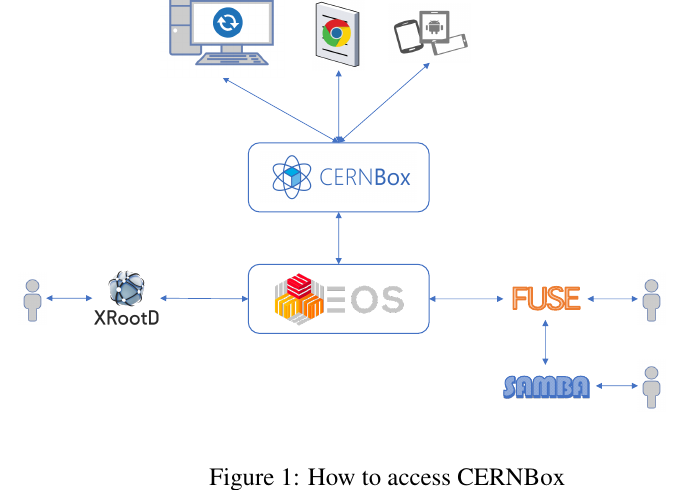
Figure 1: How to access